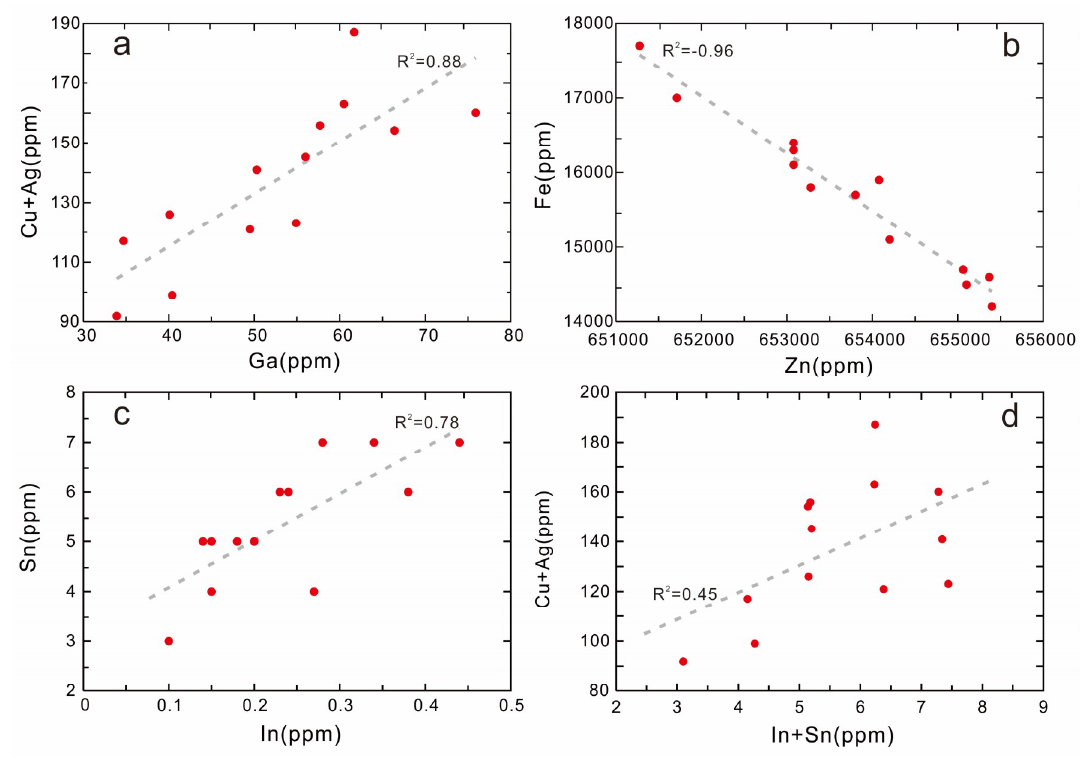
Figure 9. Correlation plots of ( a ) (Cu + Ag) vs. Ga, ( b ) Fe vs. Zn, ( c ) In vs. Sn, ( d ) (In + Sn) vs. (Ag + Cu) in sphalerite from the Nayongzhi deposit. Lines of best fit and R 2 values are given. See the text for further explanation.